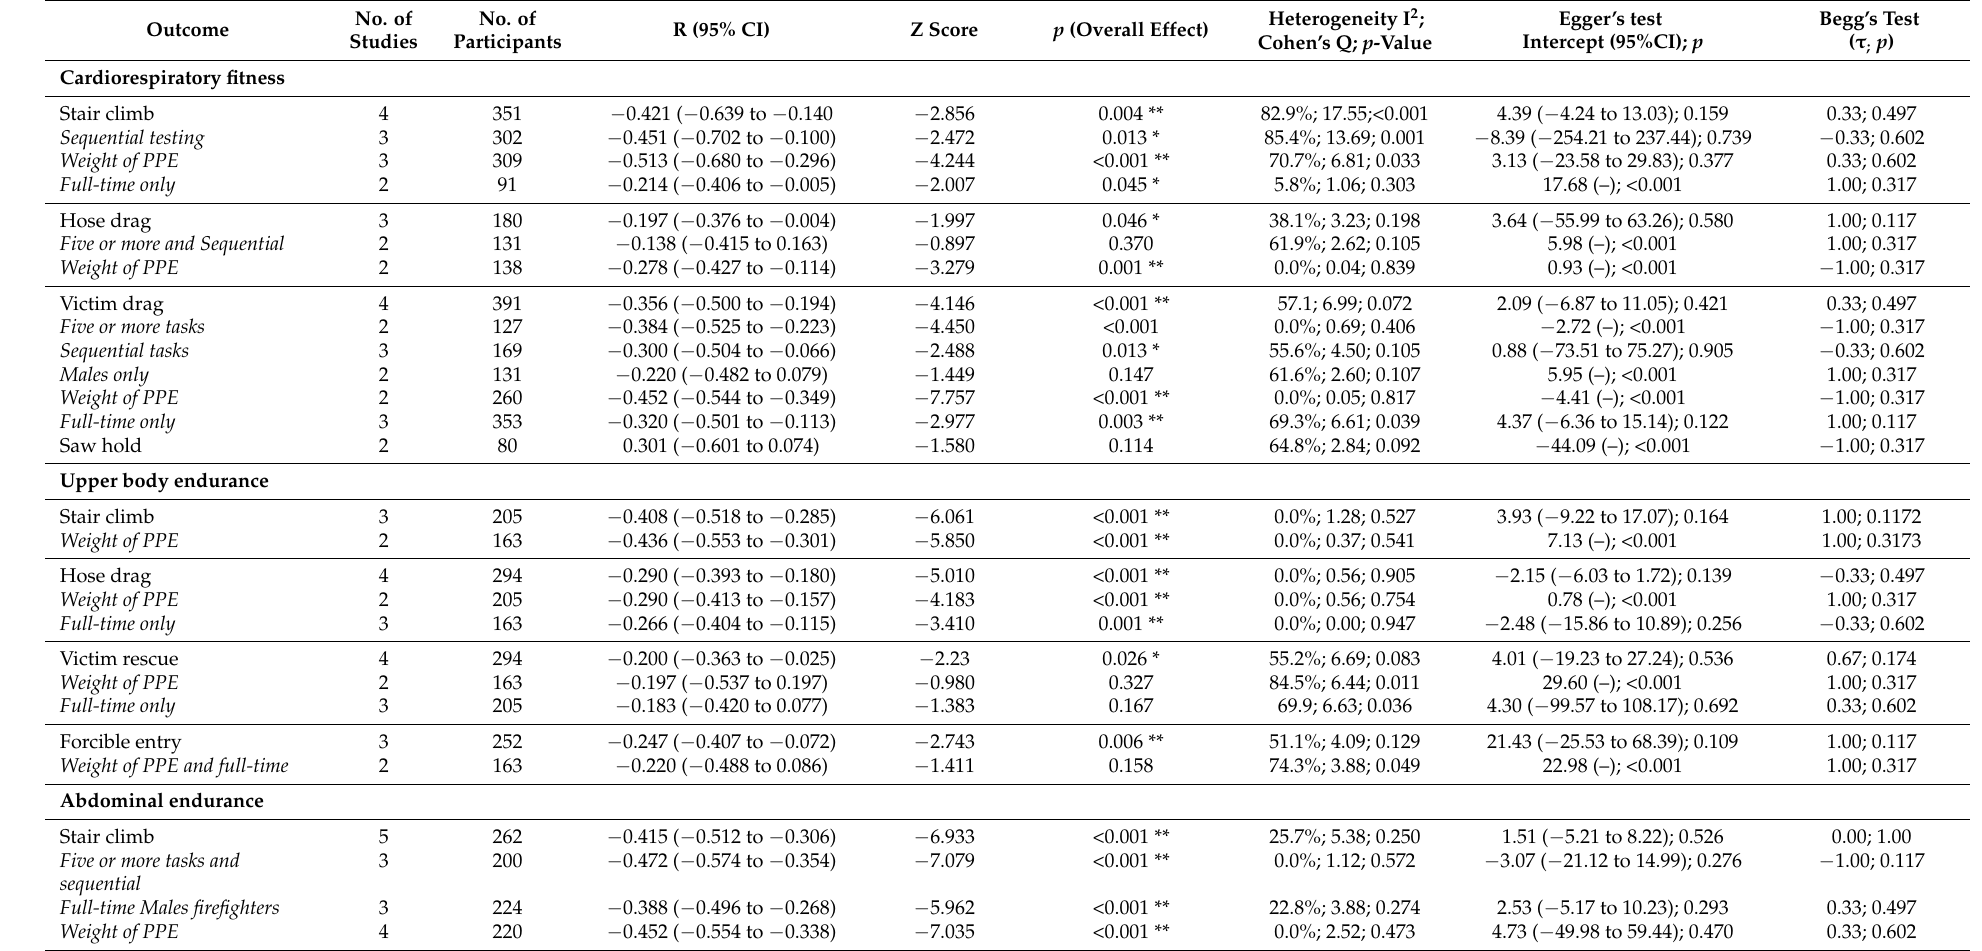
Table 7. The correlation between physical fitness and individual task